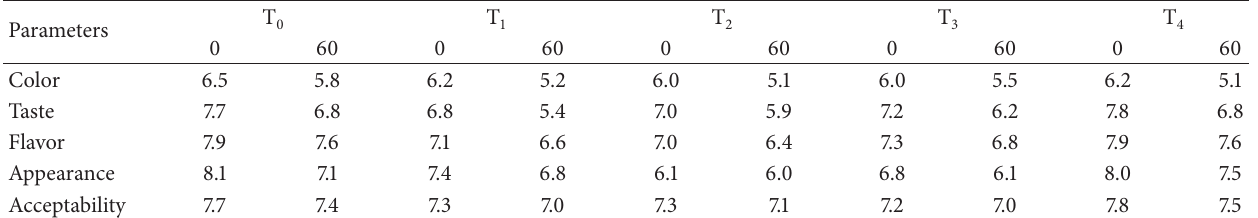
Table 6: Sensory evaluation of chicken thigh meat